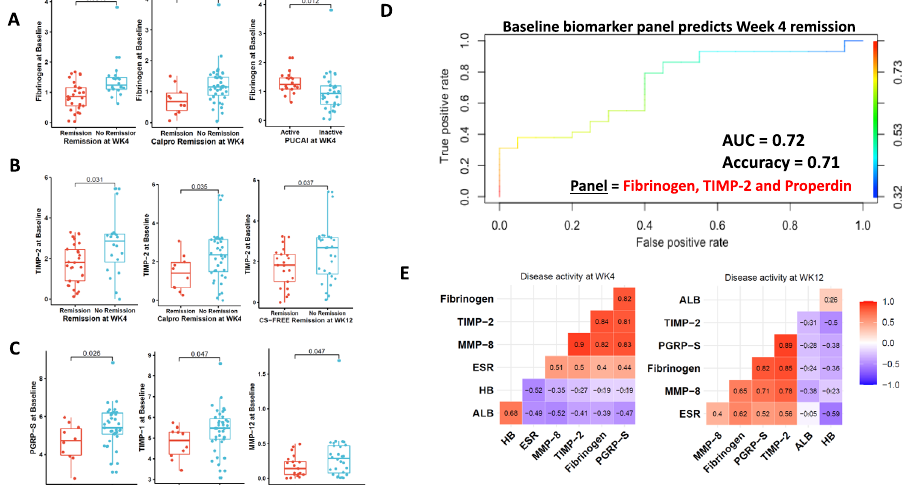
Fig. 6 Selected baseline stool proteins predict clinical and treatment outcomes in UC. A Boxplots for stool Fibrinogen at baseline parsed by WK4 clinical outcome. WK4 Remission, WK4 Calprotectin-de fi ned Remission, and WK4 PUCAI active disease show sign fi icant association with fecal Fibrinogen at baseline ( p < 0.05). B Boxplots for stool TIMP-2 at baseline parsed by WK4 Remission, WK4 Calprotectin-de fi ned Remission, and WK12 CS-FREE Remission. C Boxplots for other signi fi cant associations. Shown are stool PGRP-S, TIMP-1, and MMP-12 proteins at baseline plotted against WK4 Calprotectin-de fi ned Remission and WK12 CS-FREE Remission. In the boxplots, Y -axis shows log-transformed stool protein values at baseline and the X - axis shows the various clinical outcomes at subsequent follow-up time-points. In each boxplot, the middle line represents the mean value and the outer two-line bars represent the data range. The symbols outside the bar range indicate outliers. Shown p -values were calculated using two-sided Wilcoxon Test in R. D After adjusting for age, gender, ethnicity and medication use, a 3-marker panel comprised of stool Fibrinogen, TIMP-2, and Properdin measured at baseline best predict clinical remission at W4, with an accuracy of 0.71 (AUC = 0.72; 95% CI: 0.57 – 0.87), as determined using elastic-net regularized logistic regression. E A pairwise Pearson ’ s correlation was performed for the selected stool markers against conventional blood markers (Hemoglobin (HB), ESR (Erythrocyte sedimentation Rate), and Albumin (Alb) at WK4 or WK12. Correlations that are not signi fi cant ( p > 0.05) are crossed